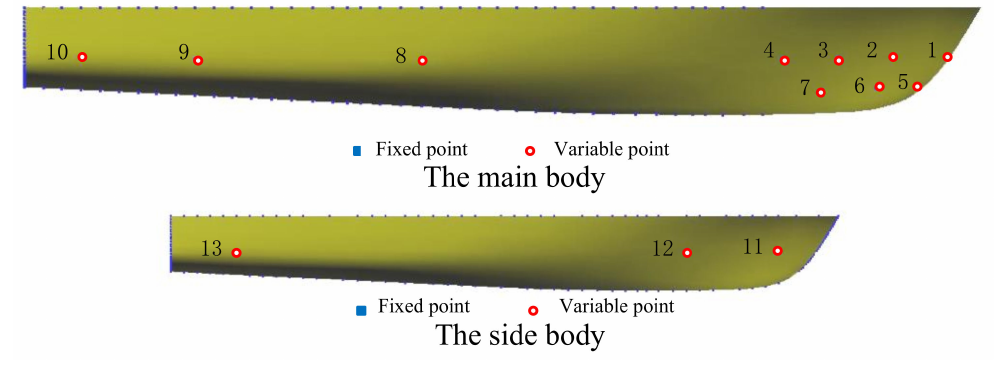
Figure 11. Location of selected points. Table 11. Values of design